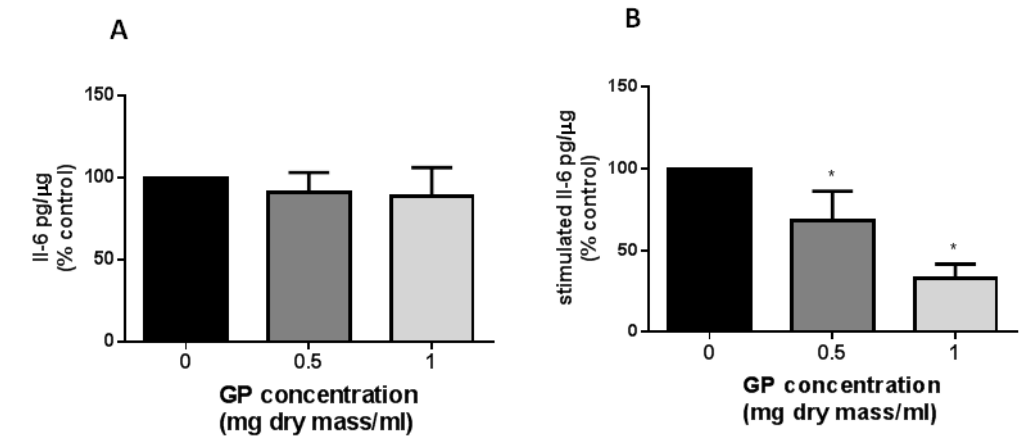
Figure 3. Effect of G. parviflora extract (GP) on IL-6 release by endothelial cells. Cells were treated with a GP extract in the absence ( A ) or presence ( B ) of Il- 1β (1 ng/mL) for 24 h. The data were derived from four independent experiments and are expressed as a parentage of control (mean ± SD). The IL-6 release was detected as pg/µg cell protein. Asterisks represent a significant difference when compared to control cells (* p < 0.5).